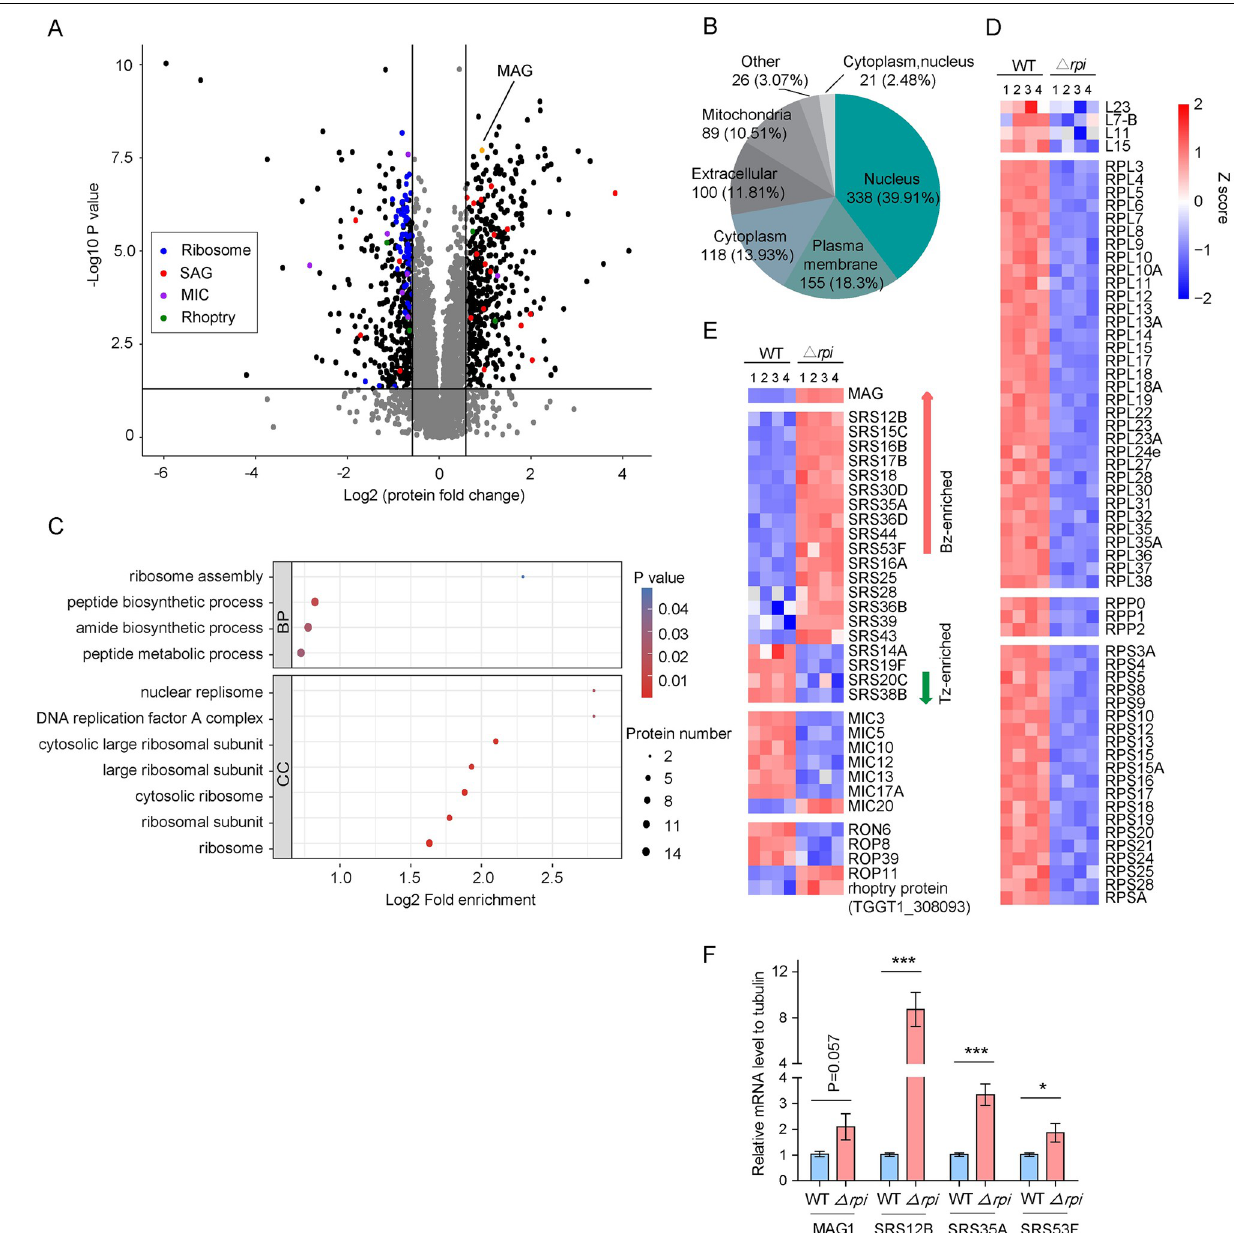
Fig 6. Tg RPI depletion alters the global proteomic profile. (A) , Volcano plots showing the protein expression difference based on 4D label-free quantitative proteomic data of Δ rpi mutants. The X-axis shows log2 (1.5-fold change) versus the Tg RPI-cKD, and the Y-axis shows -log10 ( P value) after ANOVA statistical test for n = 4 independent biological replicates. (B) , Putative subcellular localization of differentially expressed proteins. (C) , Enrichment and clustering analysis of the quantitative proteomics data sets based on gene ontology, only proteins that changed � 1.5-fold in relative ratios ( P < 0 . 05 ) were considered. BP, biological process; CC, cellular component. (D-E) , Heat map of differentially expressed ribosomal proteins, microneme proteins, rhoptry proteins and stage-specific proteins. Bright red indicates a 1.5-fold change ( P < 0 . 05 ).White indicates no change. (F) , Four genes were selected for quantitative RT-PCR analysis, which examined their expression changes. The β -tubulin gene in parasites was used as an internal reference. Means ± SEM of three independent assays, � , p < 0 . 05 , ��� , P < 0 . 001 ; Student’s t-test.